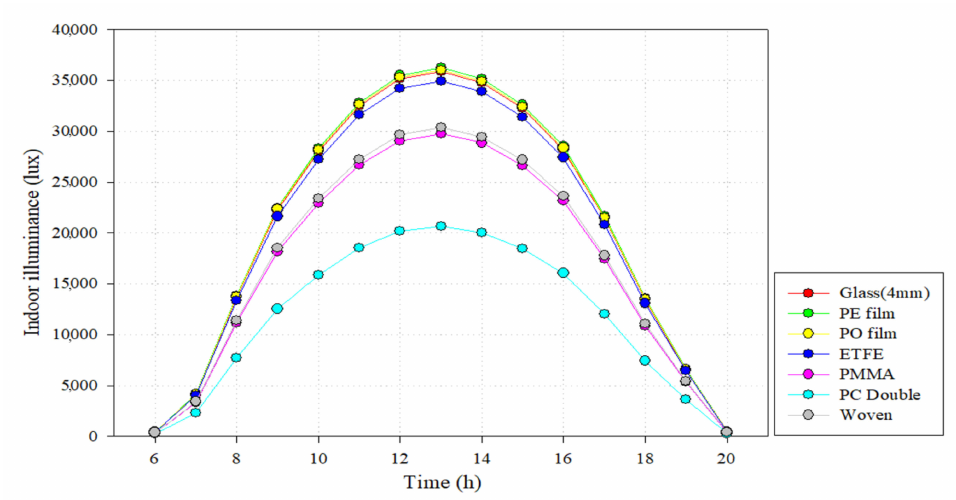
Figure 17. Interior illumination by cladding